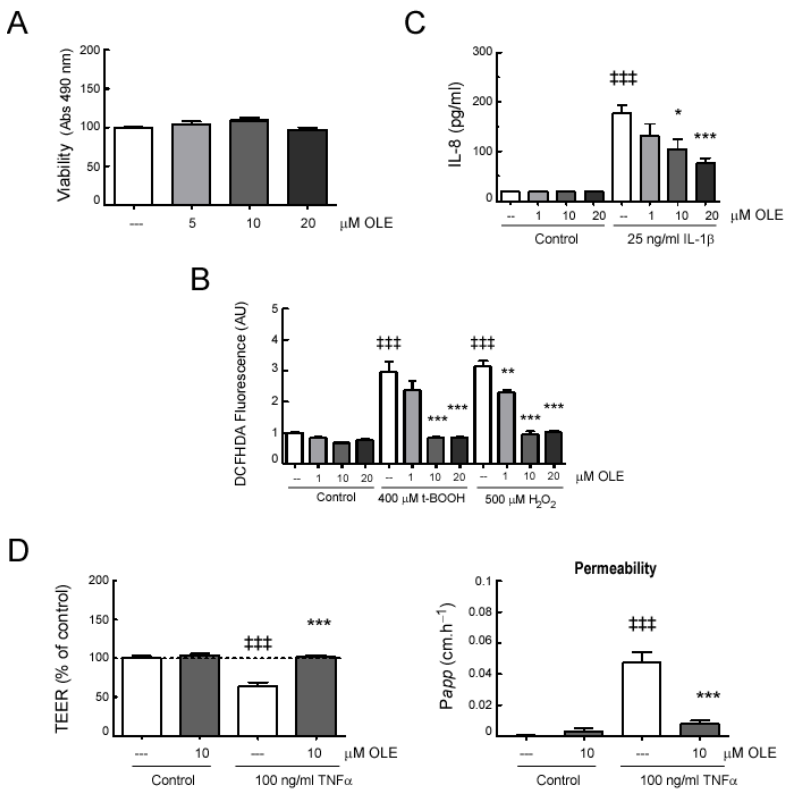
Figure 7. OLE treatment modulates responses of activated Caco-2 cell monolayers. ( A ) Caco-2 monolayers were treated for 24 h with the indicated doses of OLE and viability was measured as indicated in material and methods. Caco-2 monolayers, pretreated for 30 min with different doses of OLE, were incubated with the indicated stimuli: ( B ) After 1 h, cells were stained with DCFH-DA and intracellular ROS-production was analyzed in a microplate reader; ( C ) after 24 h, IL-8 concentration in the cell-culture supernatant was measured by commercial ELISA; and ( D ) after 24 h, trans-epithelial electrical resistance (TEER) was tested. TEER values at 24 h normalized to the untreated control (100%) and FITC-dextran (FD-40) transport. Assays were performed in duplicates, n = 3. Results were expressed as the mean ± SEM. ‡‡‡ p < 0.001 vs. control; and * p < 0.05 and ** p < 0.01 *** p < 0.001 vs. stimuli without OLE.